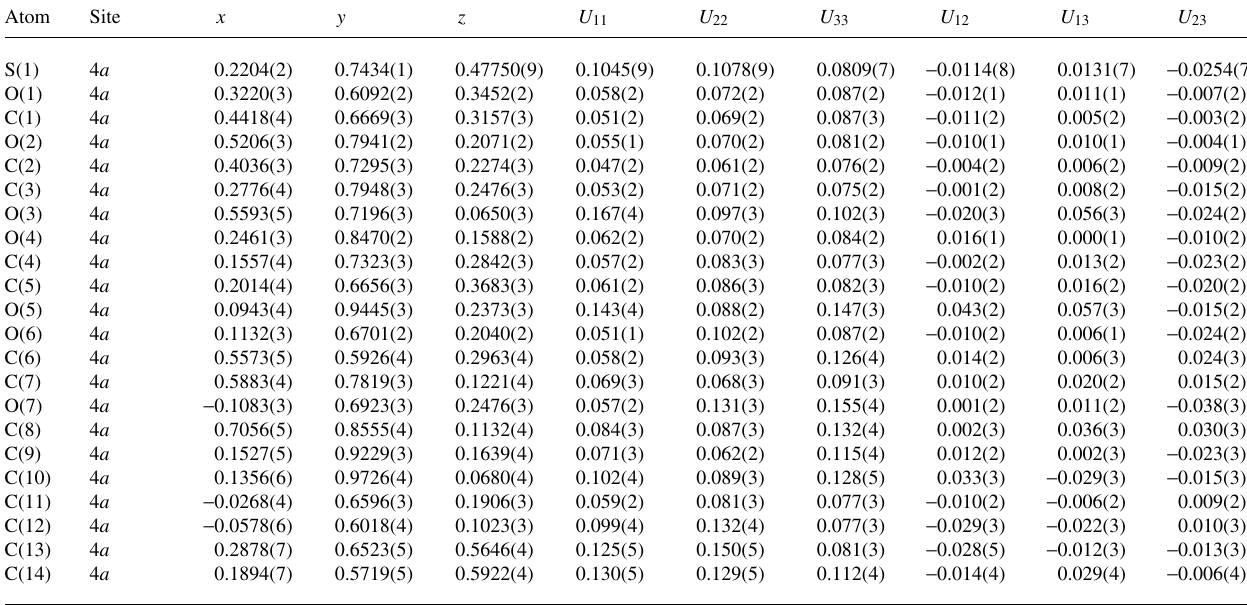
Table 3. Atomic coordinates and displacement parameters (in Å 2 )